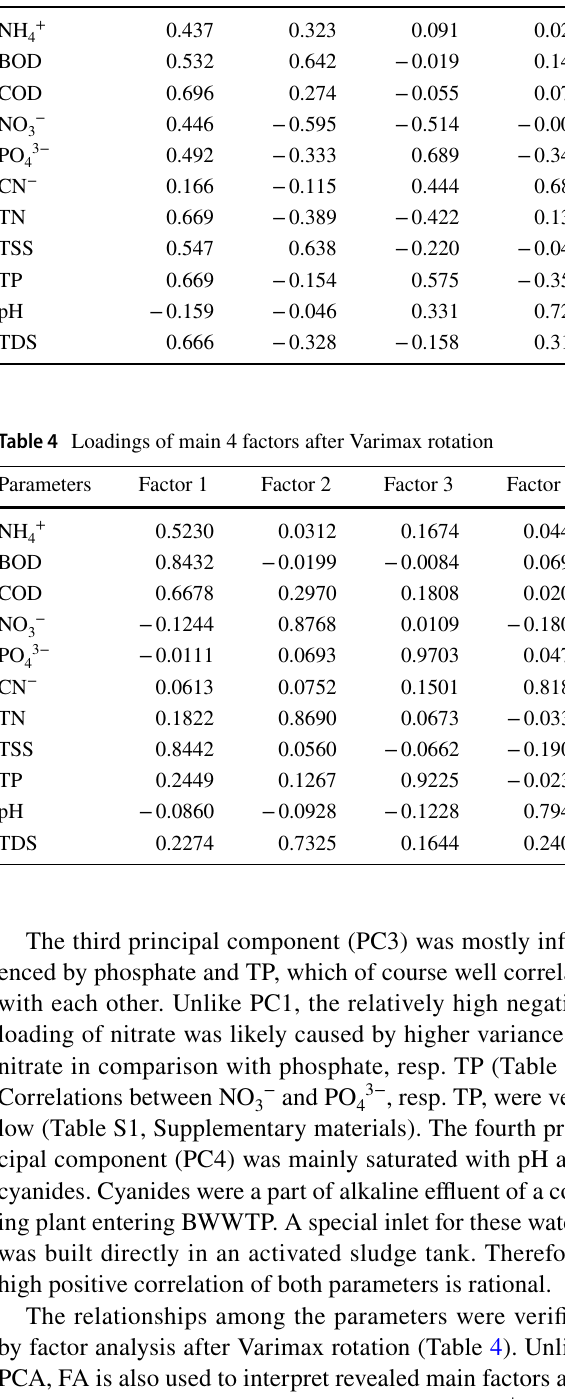
Table 3 Loadings of main 4 principal components Parameters